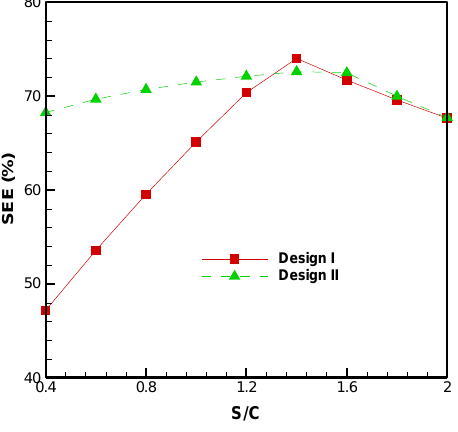
Figure 9. Effects of the S/C ratio on the system energetic efficiency of the two